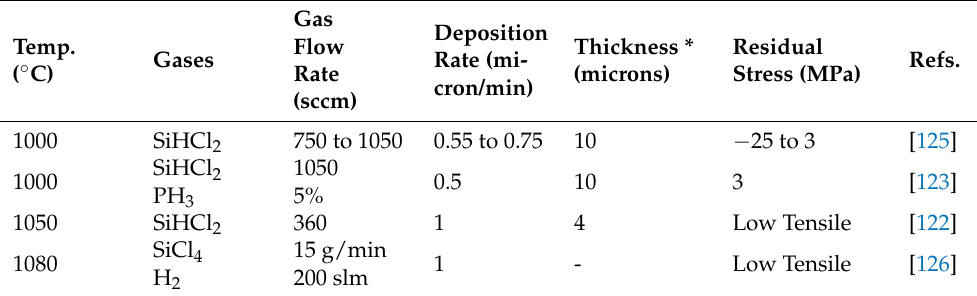
Table 12. Reported Residual Stresses of Epitaxial Thin-Films of Polycrystalline Silicon as a Function of Processing Conditions.